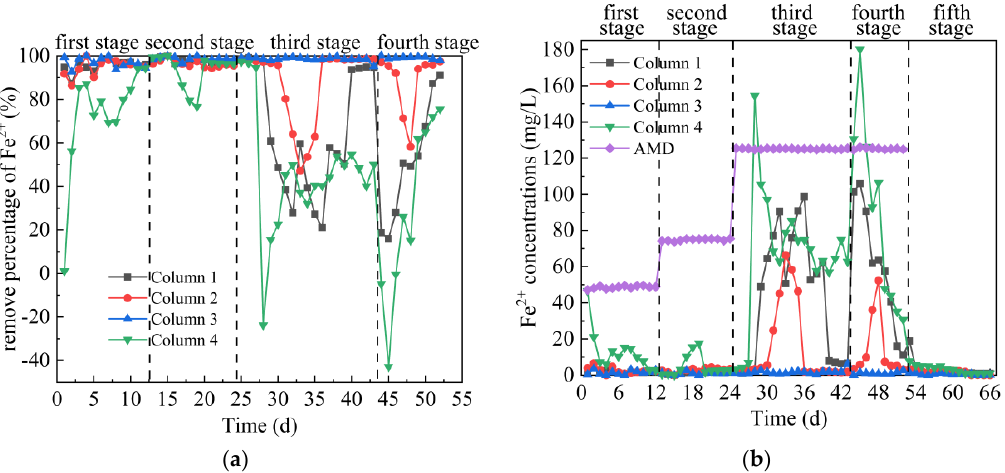
Figure 6. Changes of Fe 2+ removal effect of SRB combined with Coal Gangue 1–4 to repair AMD. ( a ) Fe 2+ removal percentage; ( b ) Fe 2+ concentration. ( a ) Fe 2 + removal percentage; ( b ) Fe 2 +